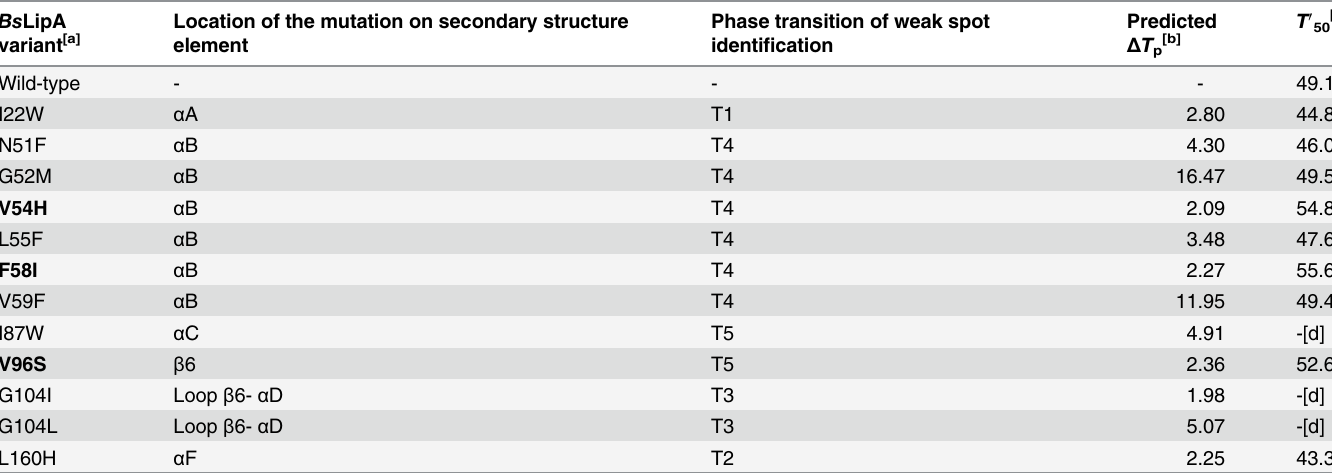
[a] Variants highlighted in bold show a signi fi cant increase in T 0 [b] Difference phase transition temperatures T [c] The temperature at which the fraction of the activity to the initial activity (at 40°C) is 50% after incubating for 30 min; in °C. [d] No activity after 30 min incubation at temperatures of 40 –